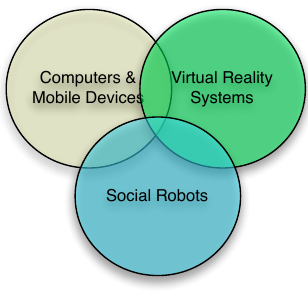
Figure 3. Three major delivery forms of technology-facilitated autism